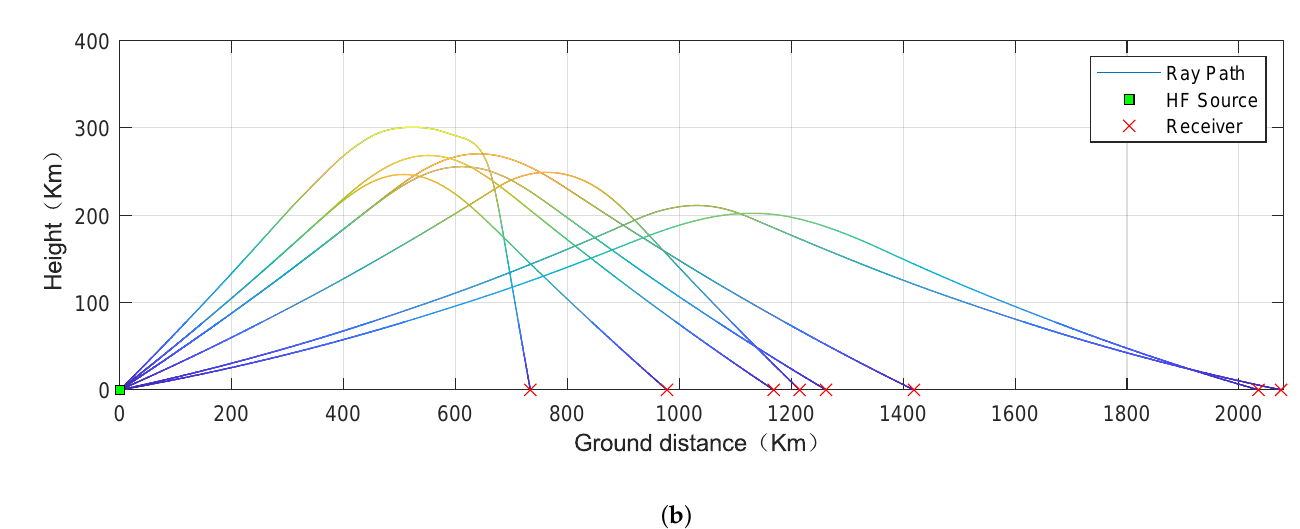
Figure A4. Simulating the HF signal path from Xi’an to eight receivers using ray tracing method. ( a ) 3D ray tracing path; ( b ) 2D ray tracing